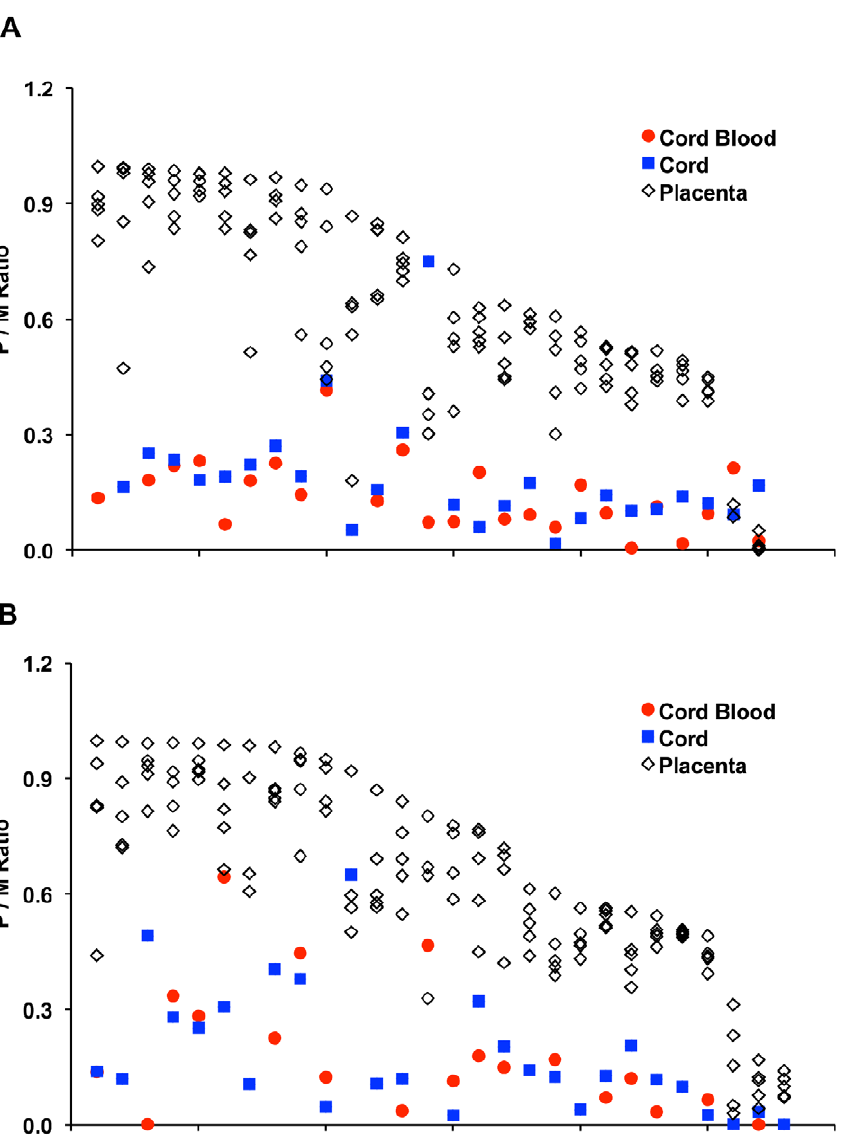
Figure 3. Allele-specific methylation at the IGF2R DMR. (A) 27 informative in vivo individuals, and (B) 28 informative in vitro individuals. P/M represents the DNA methylation ratio between paternal and maternal alleles (see text). Each individual is represented as vertical data-set of P/M ratios from cord blood, cord and five sections of placenta. Individuals were ranked based on the degree of scatter (intra-individual variation) observed.